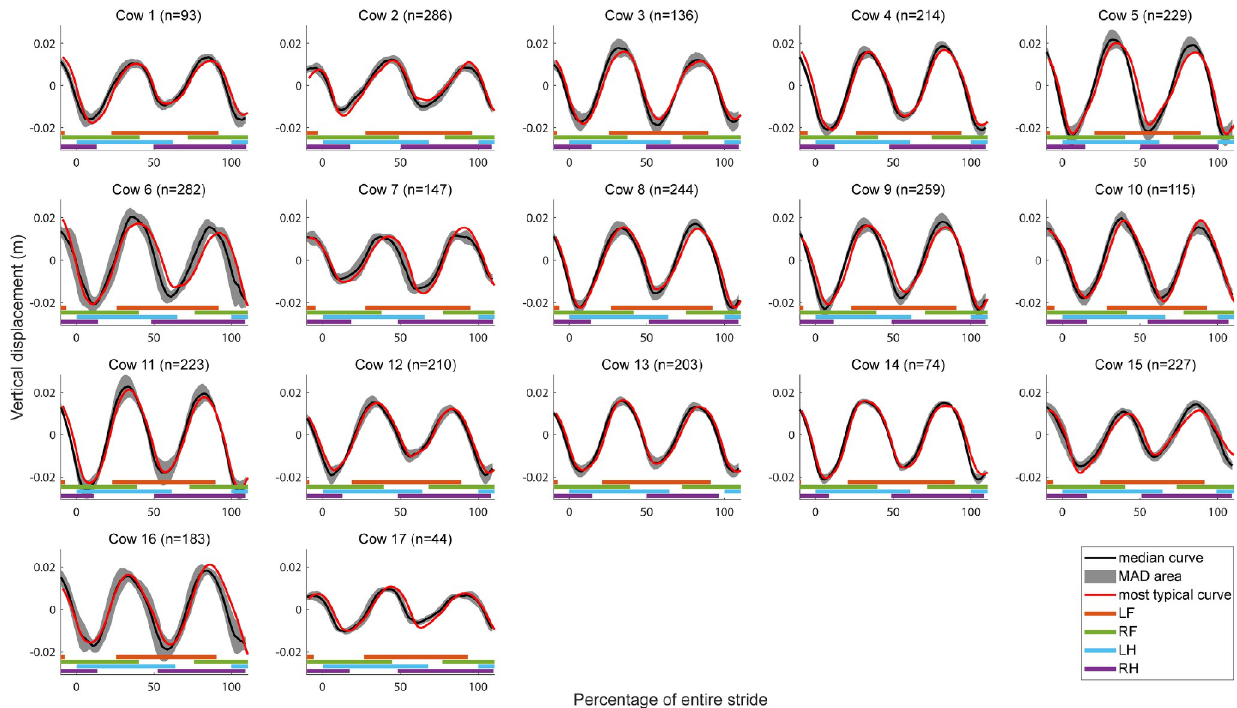
Fig 8. Vertical displacement curves of the sacrum. Per cow, the median curve (black), the MAD area (grey), and most typical curve (red) is shown on a scale from zero to 100% of the entire stride duration. The stance phases of the limbs are indicated by the horizontal lines underneath the curves (orange: LF, green: RF, blue: LH, purple: